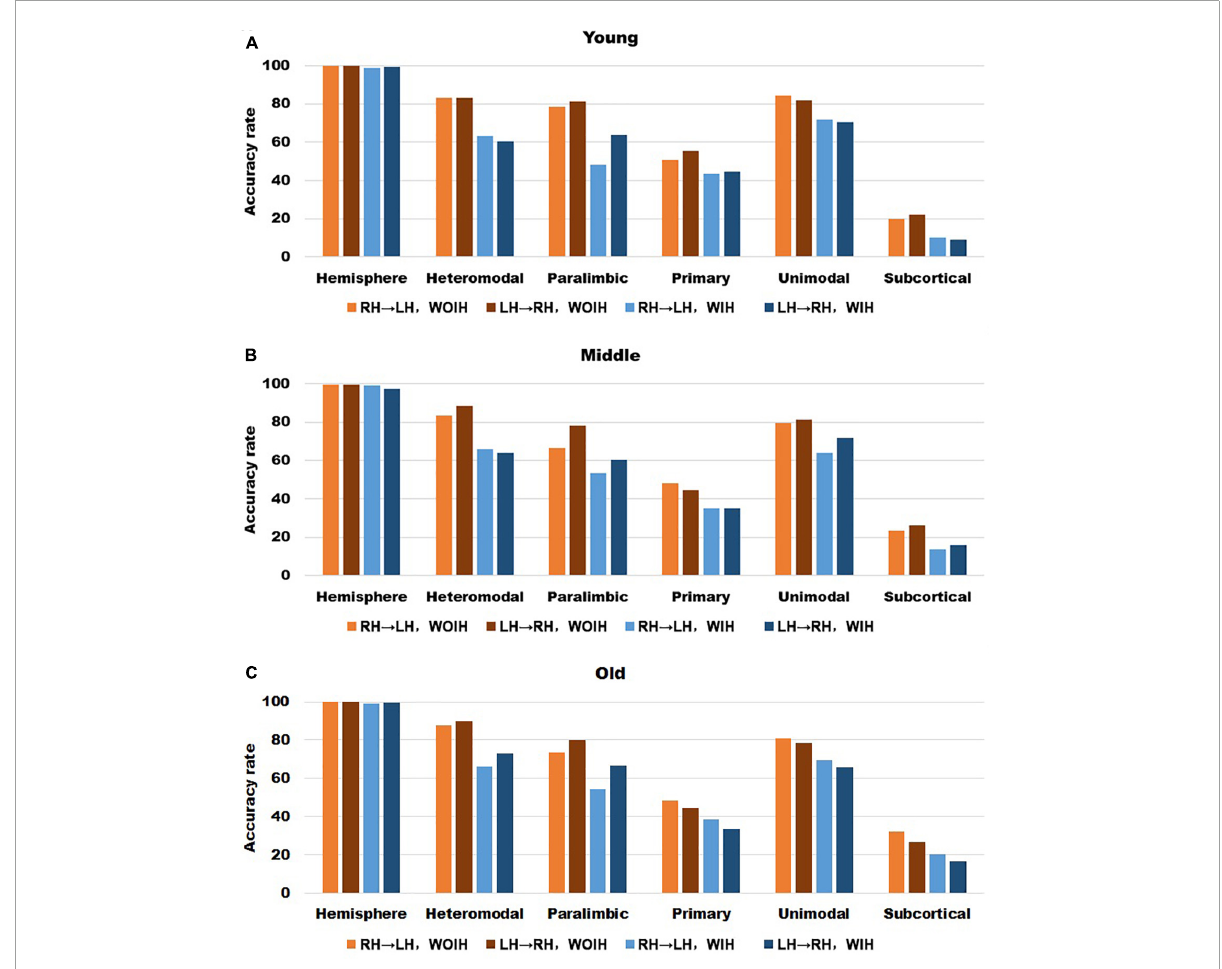
FIGURE8 The recognition rate results of hemisphere and each sub-module in different age groups for AICHA template with NGSR. (A–C) Represents the recognition rate of young, middle and old, respectively. From left to right in each sub graph, the recognition rate of hemisphere and five sub-modules are in turn. Notably, orange indicates that the RH recognizes the LH Without Ipsilateral Hemisphere (RH → LH, WOIH). Brown indicates that the LH recognizes the RH Without Ipsilateral Hemisphere (LH → RH, WOIH). Light blue indicates that the RH recognizes the LH With Ipsilateral Hemisphere (RH → LH, WIH). Dark blue indicates that the LH recognizes the RH With Ipsilateral Hemisphere (LH → RH,